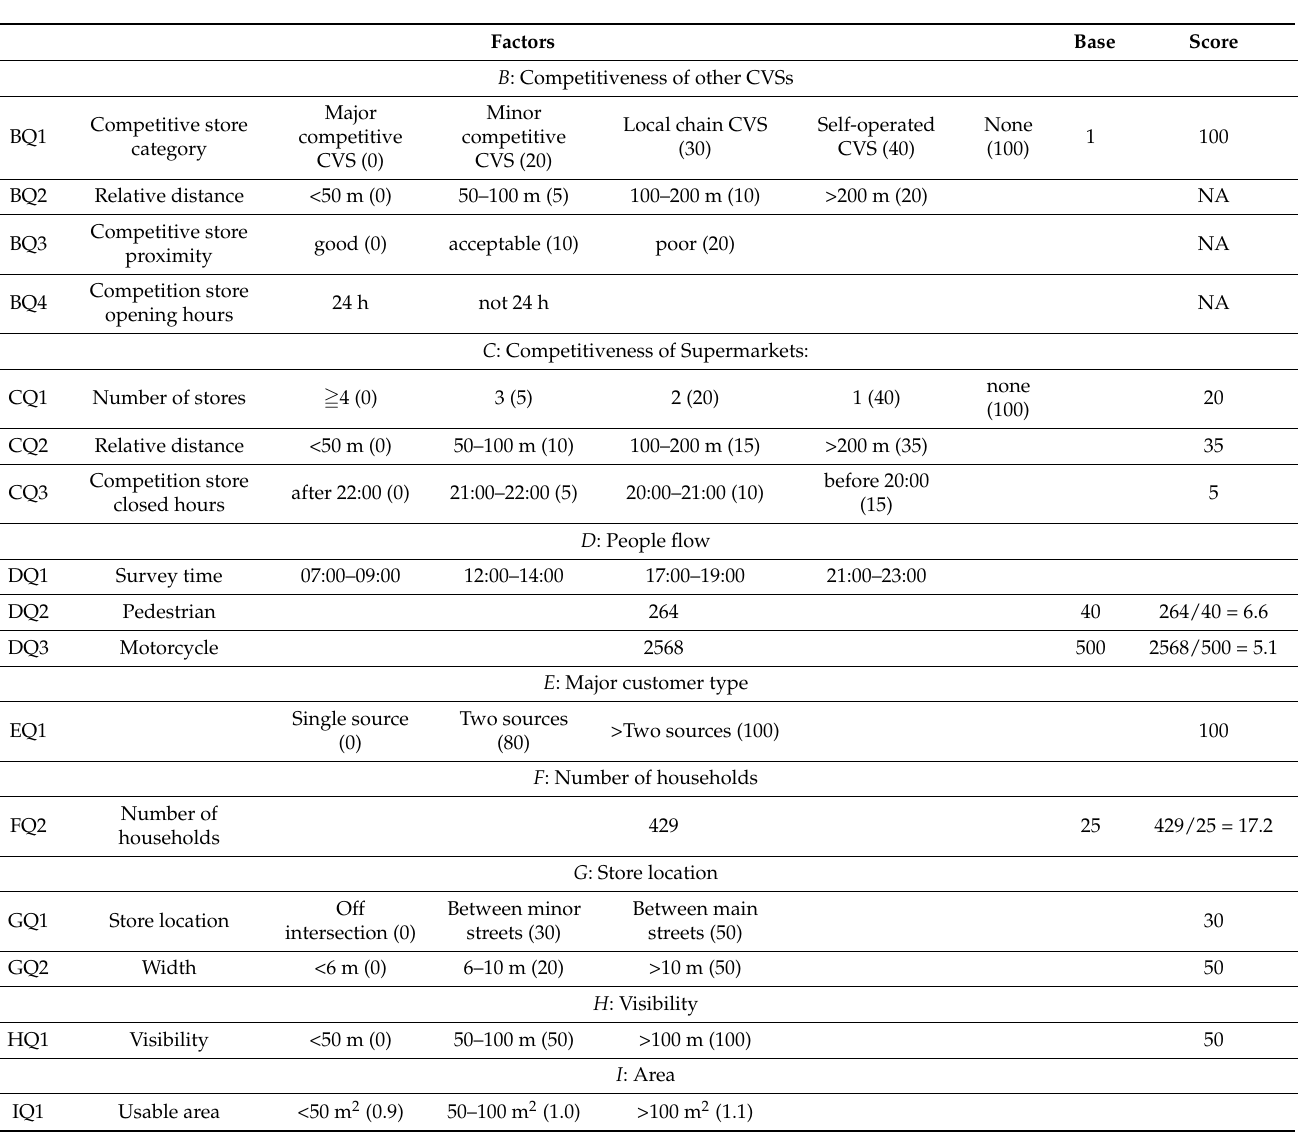
Table 3. Scores of the factors.